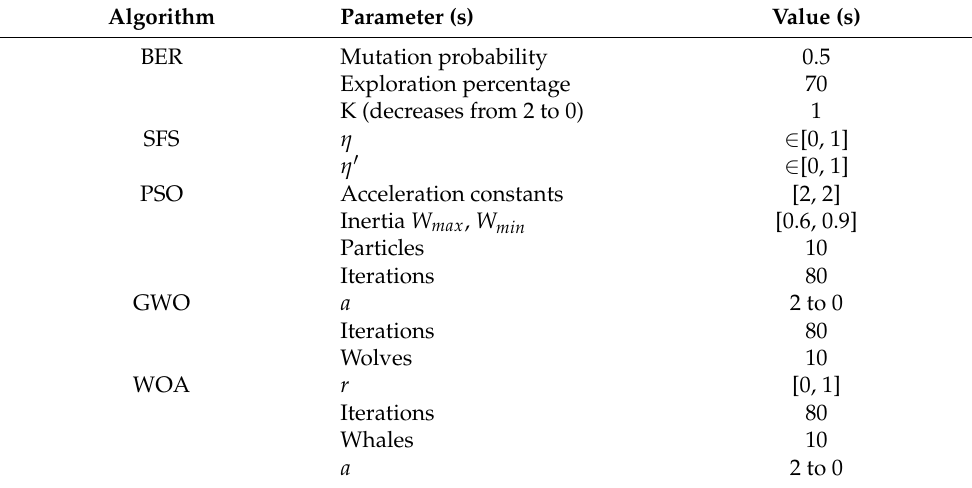
Table 10. Parameter settings for the methods being compared.